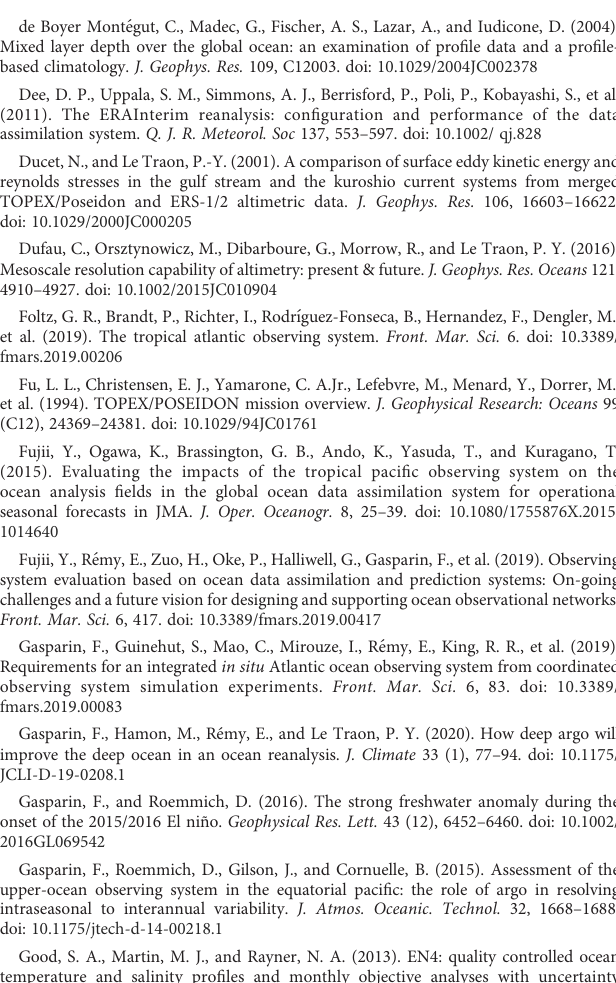
SUPPLEMENTARY FIGURE 1 Amplitude of errors (both representation and instrumental) associated to synthetic observations for 100-m temperature and 10-m salinity: (A, C) spatial maps, (B, D) zonally averaged (black line). As a comparison, zonally averaged prescribederrorintheoperational systemisalsoshowninredline.Amplitudeof synthetic observation errors (both representation and instrumental errors) in synthetic observations for 100-m temperature: (A) spatial maps, (B) zonally averaged (black line) and for 10-m salinity (C) spatial maps, (B) zonally averaged (black line). As a comparison, zonally averaged prescribed error in the operational system is also shown in red line in (B) and (D) . SUPPLEMENTARY FIGURE 2 Amplitude of errors in synthetic temperature observations at three moorings locations in the equatorial Paci fi c (165°E, 140°W, 110°W). For comparison to the error estimate (black lines), prescribed errors in the operational system (red lines) and high-frequency variability from moorings (<7 days; blue crosses) are